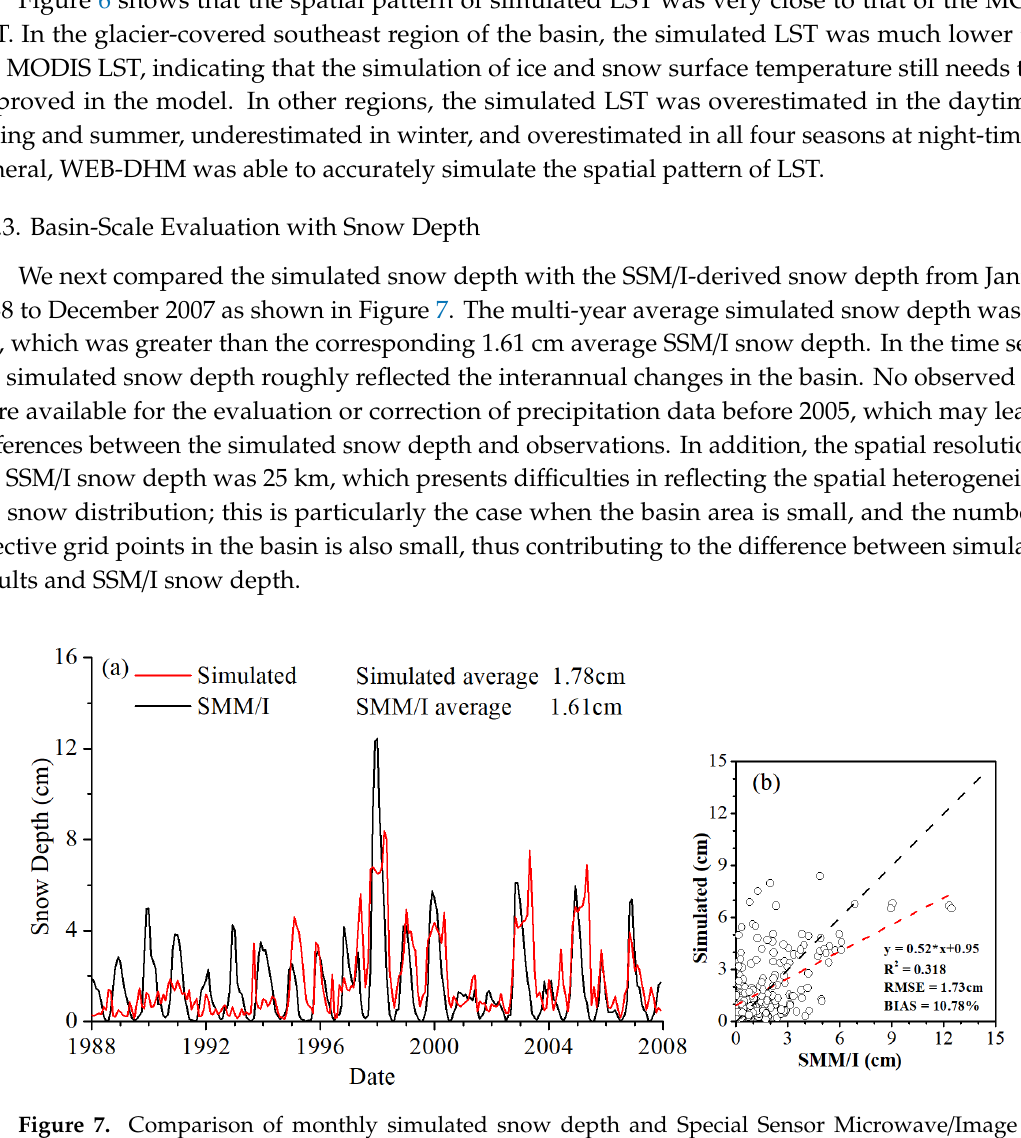
Figure 7. Comparison of monthly simulated snow depth and Special Sensor Microwave / Image (SMM / I)-derived snow depth in ( a ) time-series and ( b )